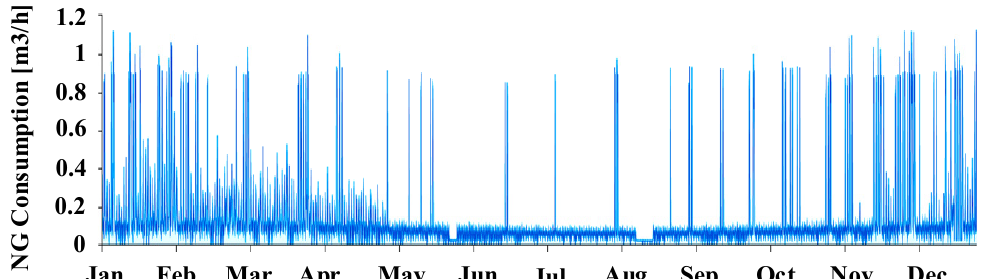
Figure 12. Daily NG consumption of the boiler and FC.